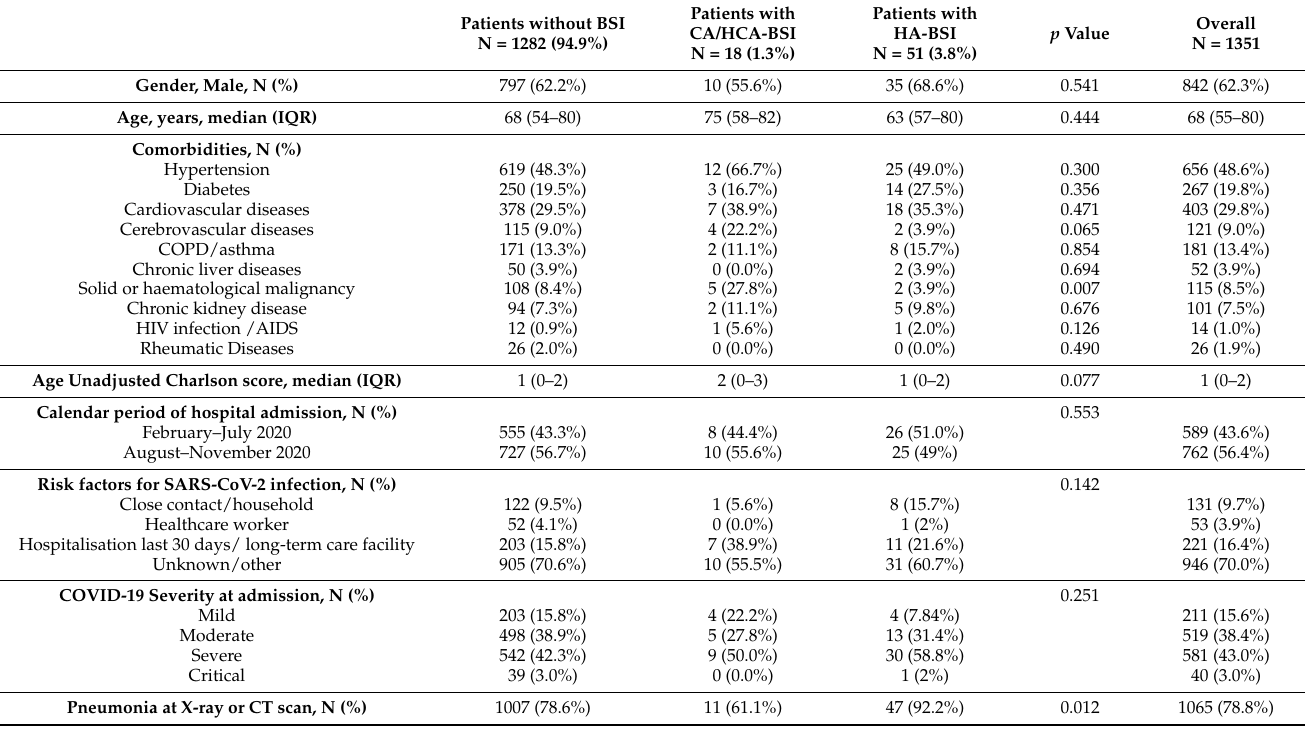
Table 1. Demographics and clinical characteristics of 1351 patients hospitalised with COVID-19.